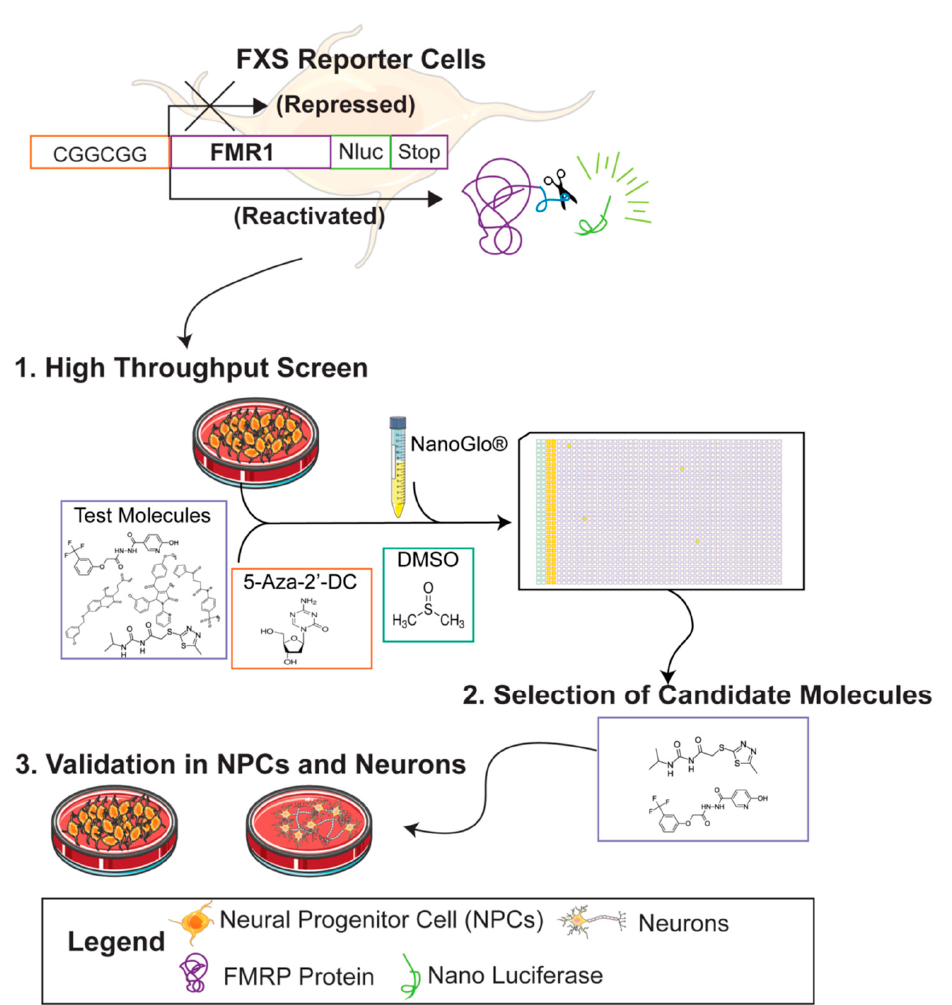
Figure 1. Graphical abstract for drug screen to identify reactivators of the FMR1 Figure 1 . Graphical abstract for drug screen to identify reactivators of the FMR1 gene.